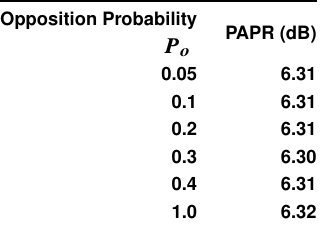
(a) Total (b) Detailed view